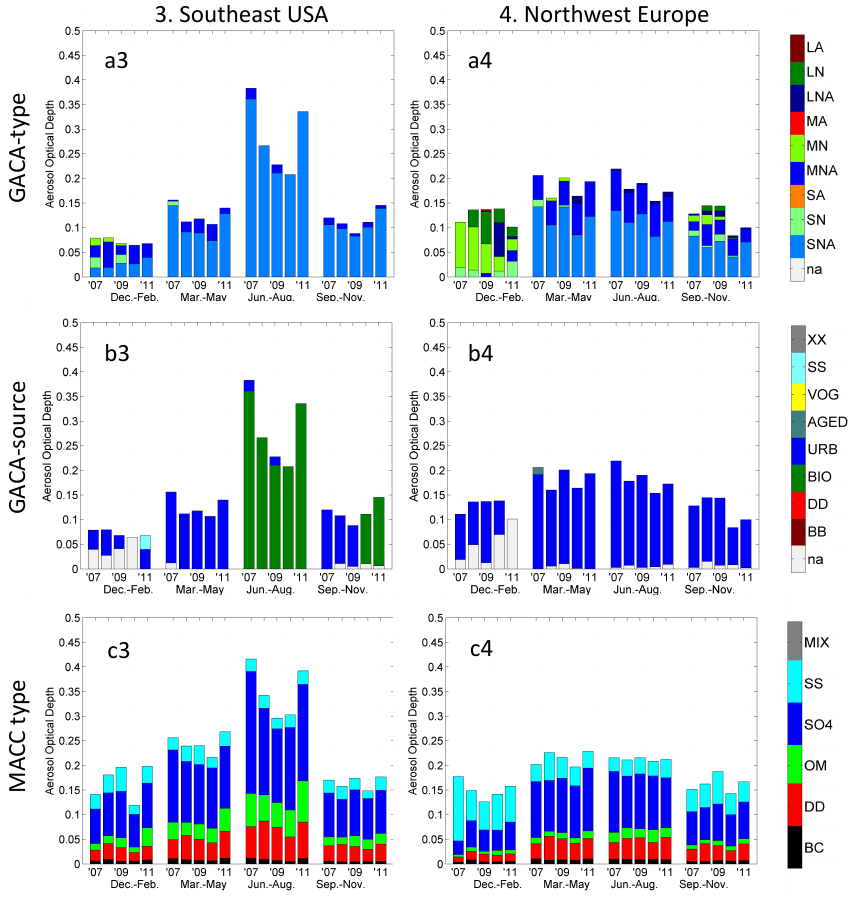
Figure 11. Seasonal cycles of global aerosol type and source according to GACA and MACC for 5 ◦ × 5 ◦ regions in southeastern USA (30–35 ◦ N, 80–85 ◦ W) and northwestern Europe (48–53 ◦ N, 3–8 ◦ E). See Fig. 10 for